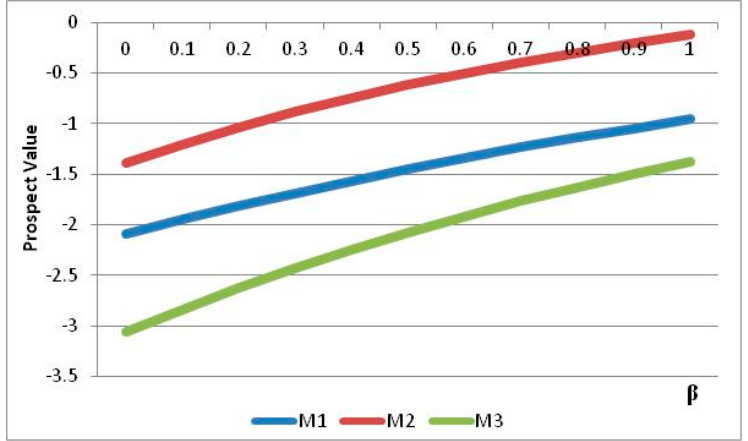
Figure 4. The integrated prospect values of three micro-grid planning programs with different α values.